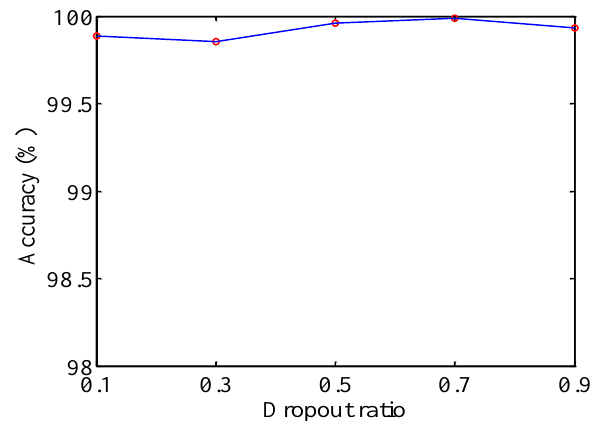
Figure 16. Classification accuracy under the different dropout ratios.